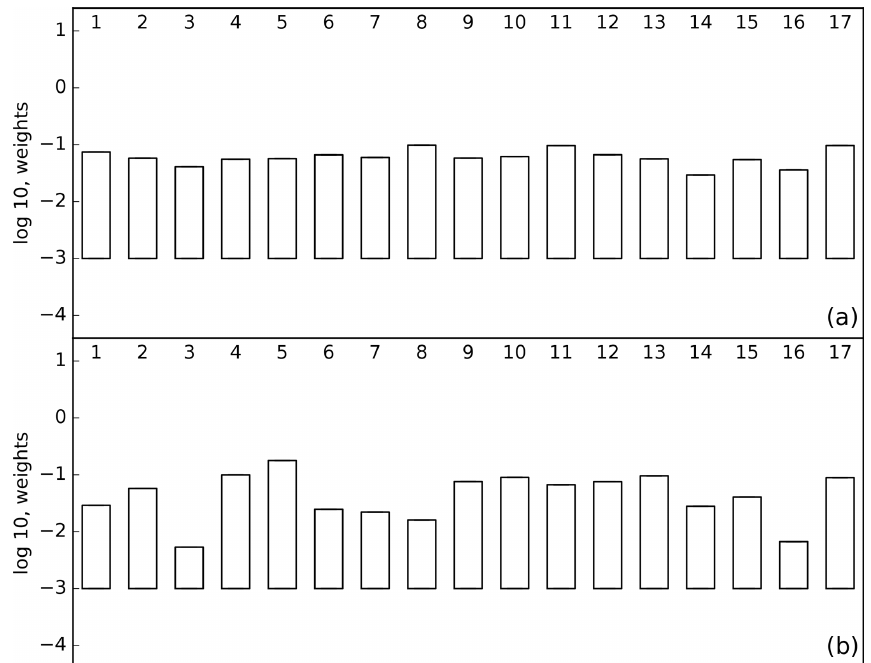
Figure 4. The log 10 of p( H i | y ) for the prior (a) and posterior (b) with p( H i | y ) calculated using nine airborne measurements over Cape Grim and Colorado.